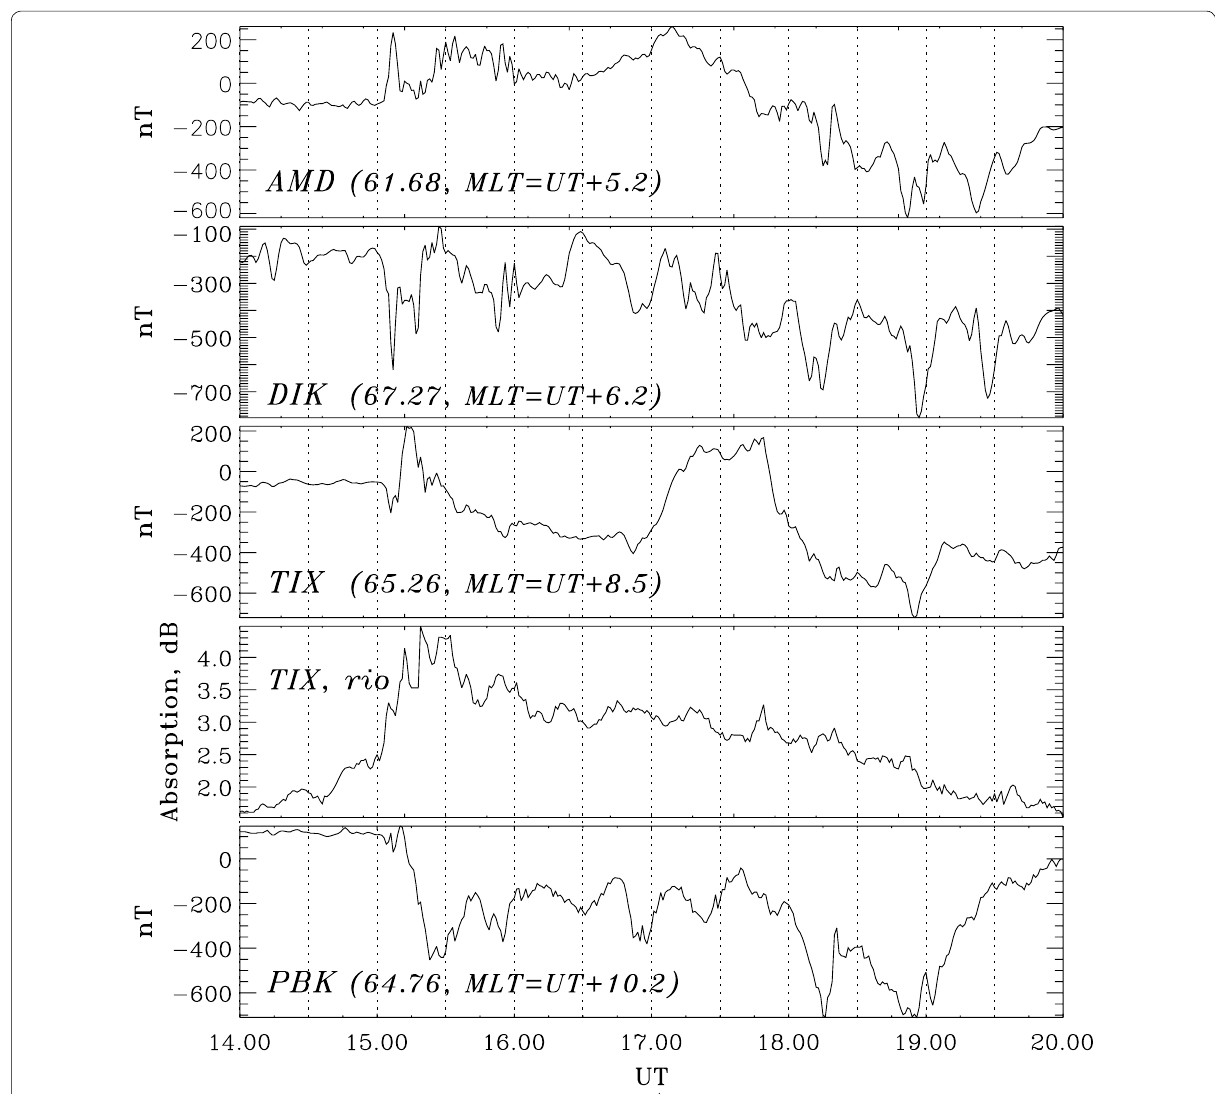
Fig. 4 Data from the Russian Arctic shore magnetometers (X-component in 10 4 nT) AMD, DIK, TIK, and PBK and riometer TIX during the period 1400–2000 UT. Geomagnetic latitudes and LT are indicated near the station